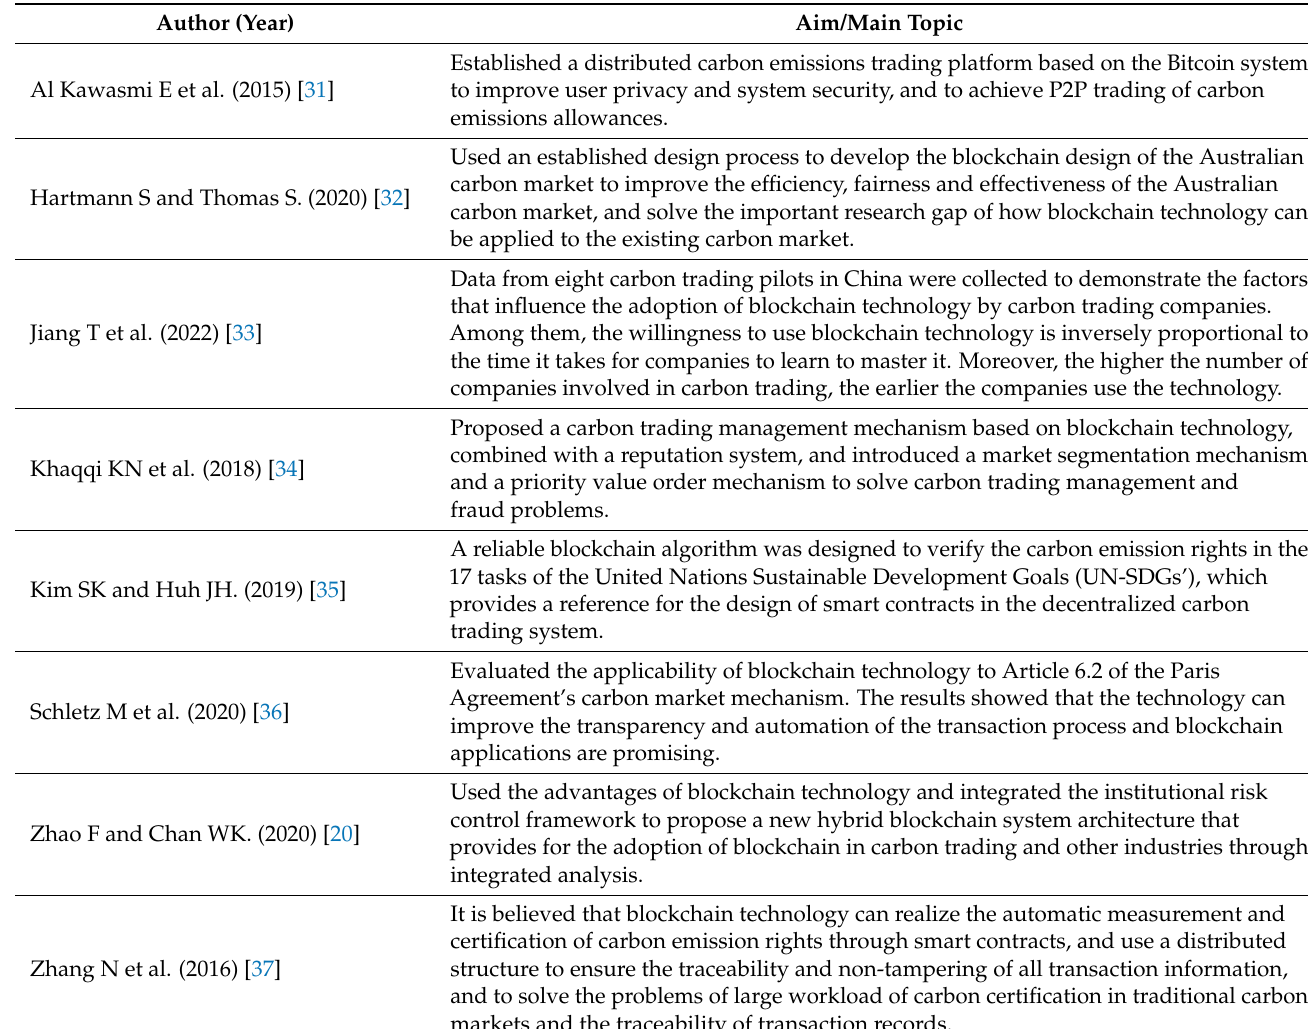
Table 1. Related research on the application of blockchain technology in carbon emissions